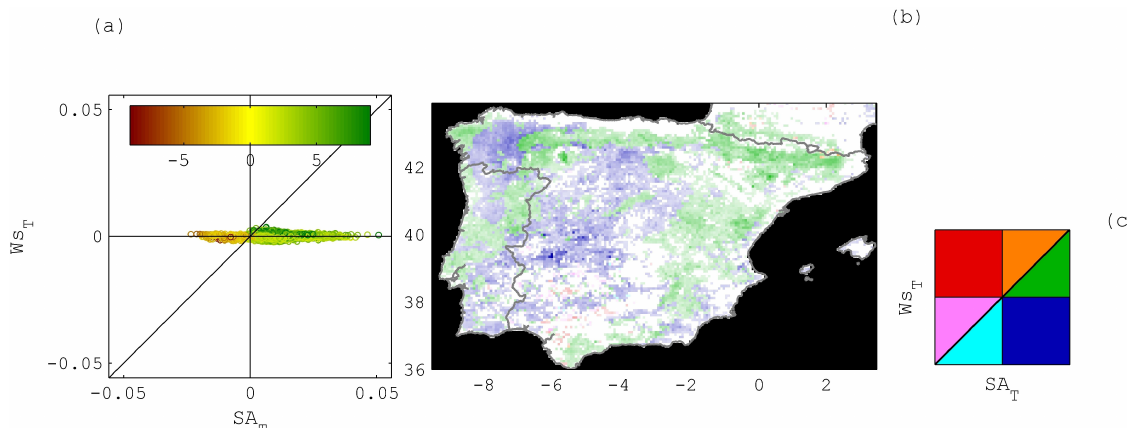
Fig. 13. Decomposition of R D trends (gCm − 2 yr − 2 ) into W s and substrate availability (SA) trends, W s H units per square meter per year) (a) . The spatial distribution of W s RH D according to its position in (a) following the diagram in (c) . The colour intensity in (b) is proportional to the magnitude of RH D T